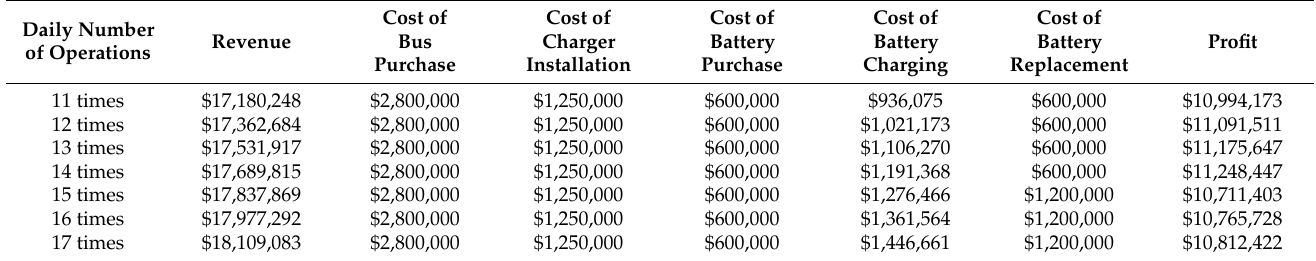
Table 4. The results according to the changes in the daily number of operations.